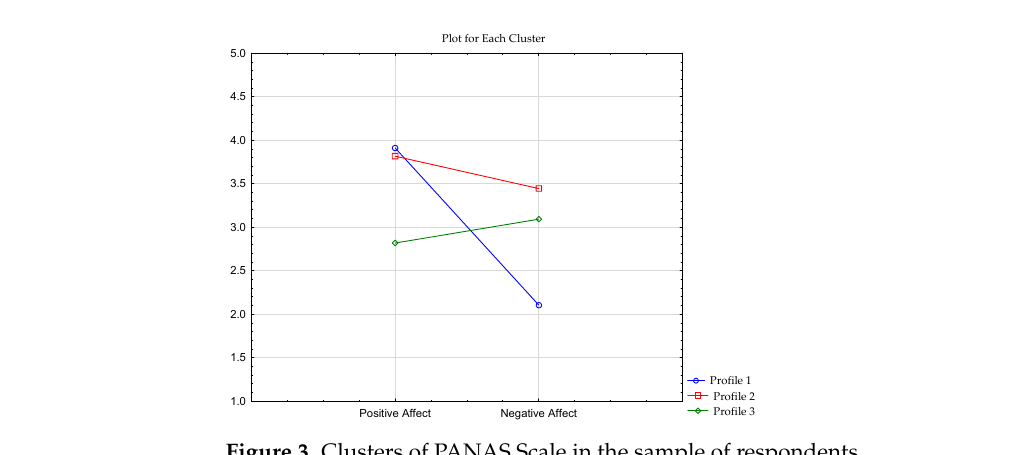
3.4. Temporal Satisfaction with Life in the Group of Mountain Hikers